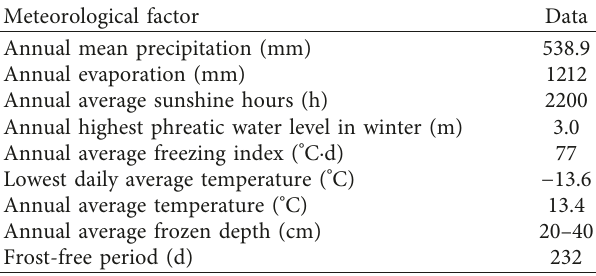
Table 1: Meteorological data for the Jinghui Irrigation Area.